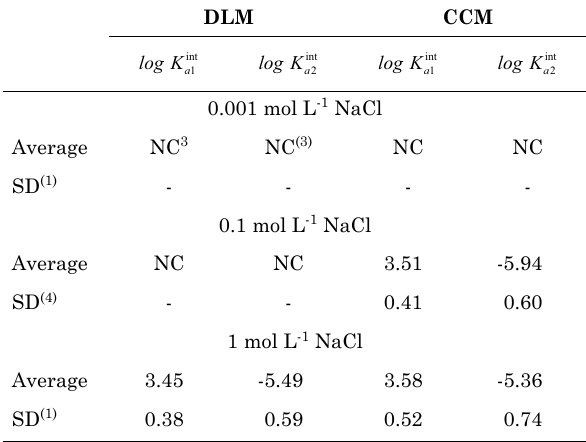
table 5. average intrinsic equilibrium constants from 17 brazilian oxisols, using the diffuse layer model (dlm) and the constant capacitance model (ccm), estimated by fiteQl 4.0 for three ionic strengths (1,2)